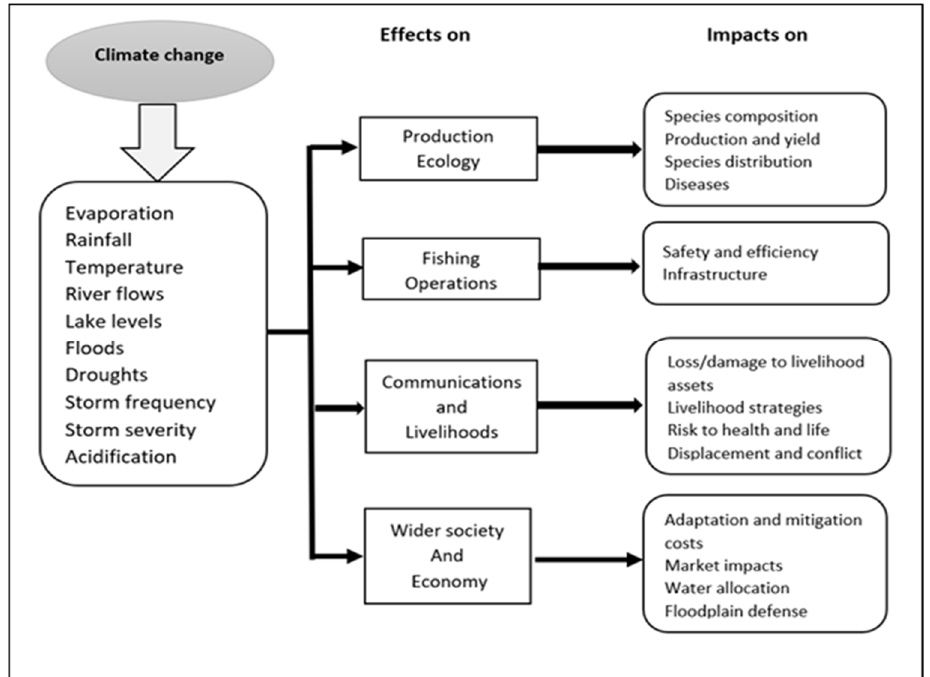
Figure 1. Impacts of climate change and variability on inland fisheries (adapted and modified from Badjeck et al. [68].